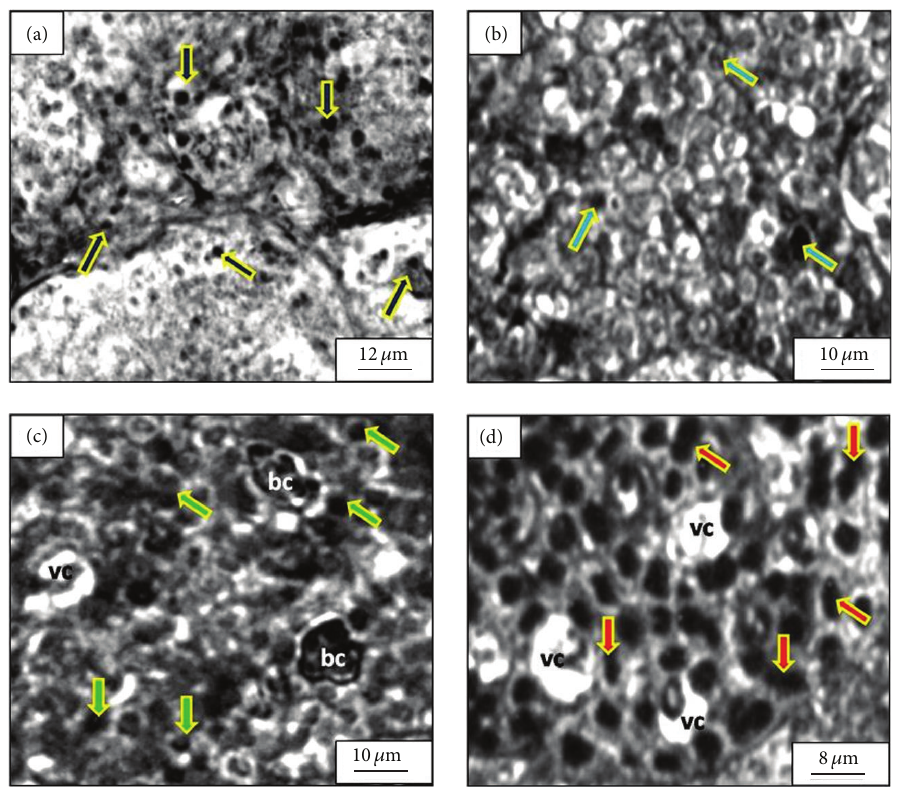
Figure 4: Transverse histological section of the corpuscles of Stannius (CS) in Mystus tengara : (a) under controlled condition few of the cells show large nuclei with agranular cytoplasmic contents (solid arrow), (b) under ZnS NP exposure (250 𝜇 g/L, 𝑑 = 3 nm, and 𝑡 = 60 days) amongst most of the cells with agranular cytoplasm few cells with darkly stained nuclei and granulated cytoplasm (solid arrow) are also visible, (c) under ZnS NP exposure (500 𝜇 g/L, 𝑑 = 3 nm, and 𝑡 = 60 days) most of the cells have dense granulated cytoplasm (solid arrows) and the nuclear volume of the cells is found to increase along with their condensed status (shown by deeply stained large nuclei), and (d) under ZnS NP exposure (1000 𝜇 g/L, 𝑑 = 3 nm, and 𝑡 = 60 days) most of the cells have been found with dense granulated cytoplasm with large elongated and dumbbell shaped (solid arrows) hyperactive nuclei with highly condensed chromatin mass (deeply stained). Some large vacuoles are not uncommon. (bc: blood cells, vc: